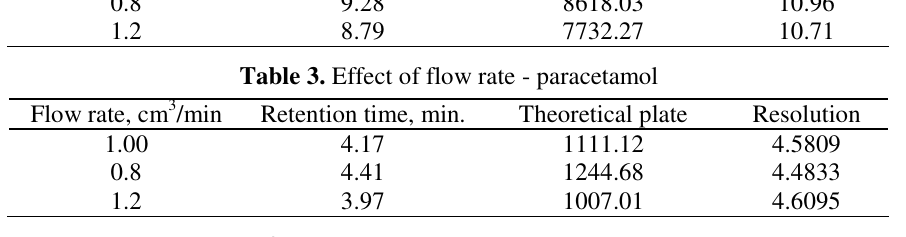
Table 4. Effect of flow rate - (diclofenac sodium)